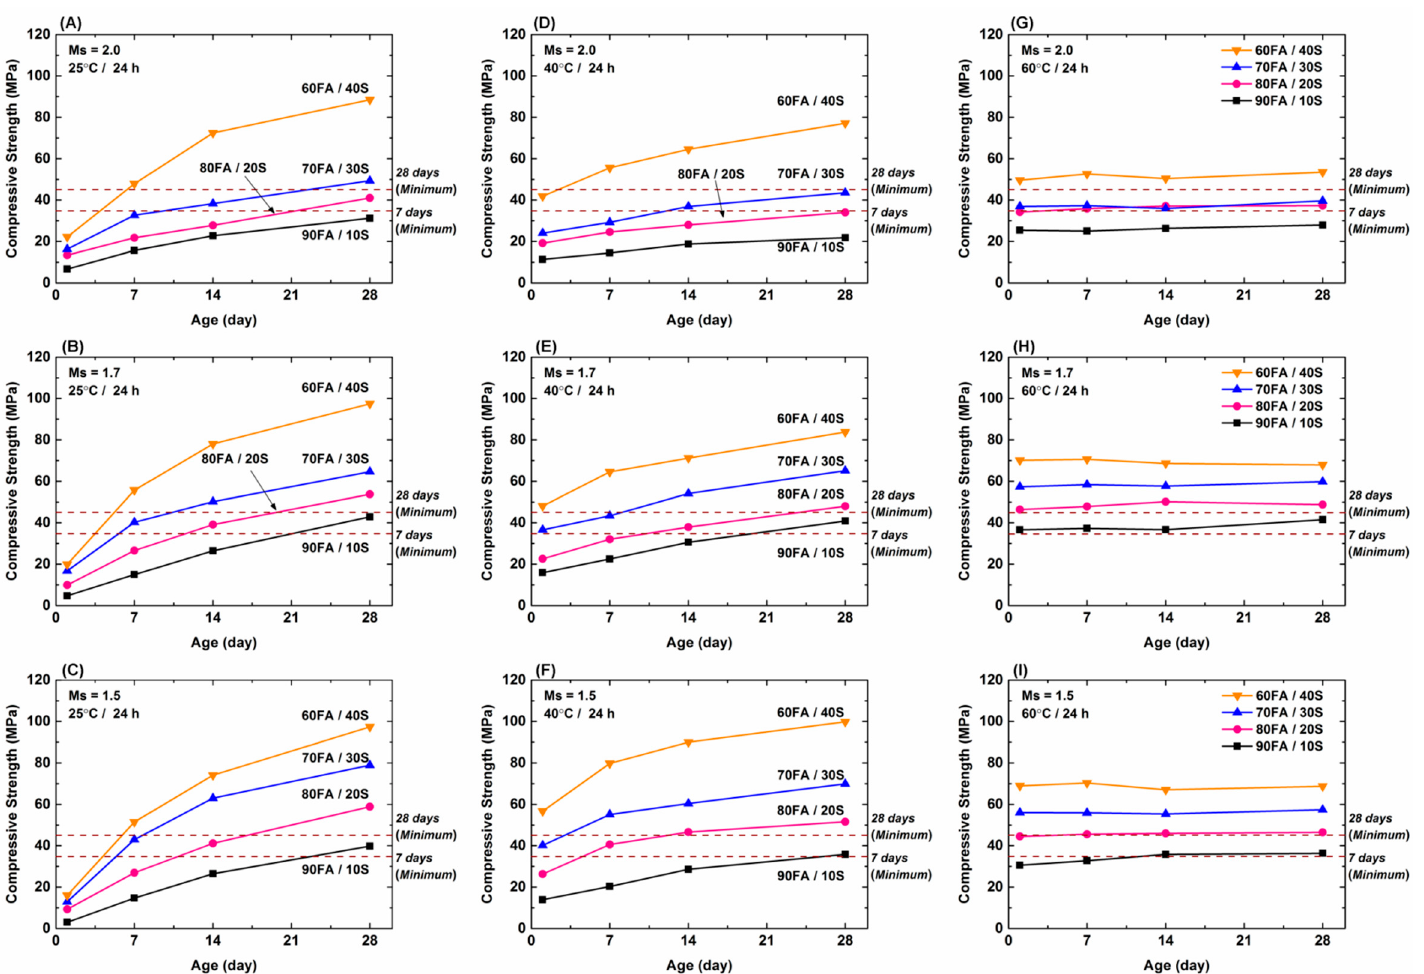
Figure 2. Effect of ageing on compressive strength development in geopolymer mortars as a function of temperature, Ms, and slag content. ( A ) Ms 2.0, Cured at 25 °C / 24 h, ( B ) Ms 1.7, Cured at 25 °C/24 h, ( C ) Ms 1.5, Cured at 25 °C/24 h, ( D ) Ms 2.0, Cured at 40 °C/24 h, ( E ) Ms 1.7, Cured at 40 °C/24 h, ( F ) Ms 1.5, Cured at 40 °C/24 h, ( G ) Ms 2.0, Cured at 60 °C/24 h, ( H ) Ms 1.7, Cured at 60 °C/24 h, ( I ) Ms 1.5, Cured at 60 °C/24 h.